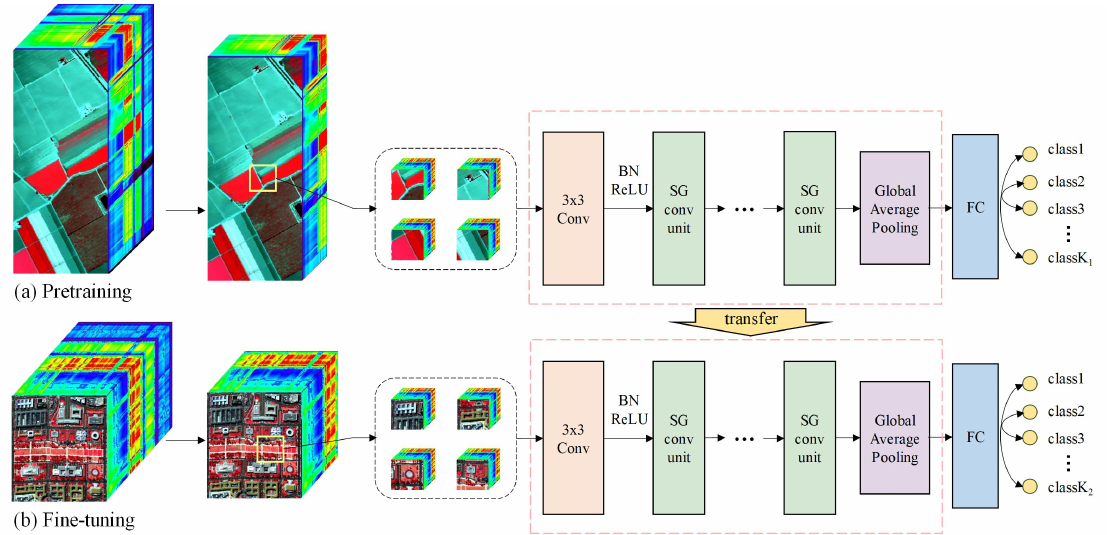
Figure 3. Transfer learning process: ( a ) pretrain the SG-CNN with samples from source HSI data, ( b ) fine-tune the SG-CNN for target HSI data classification.